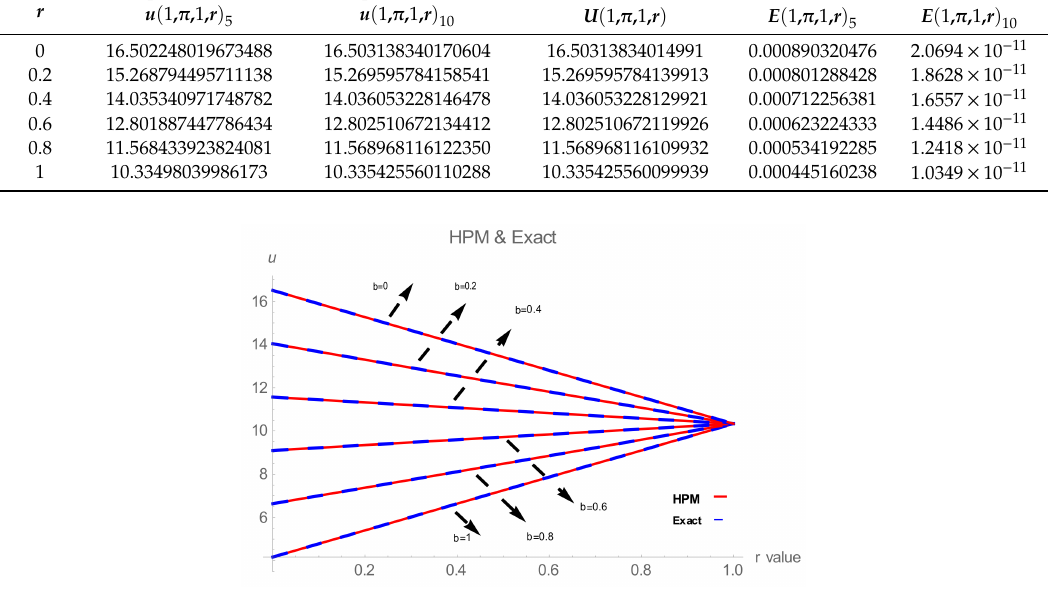
Figure 7. Comparison of the exact and tenth-order double parametric fuzzy HPM solutions of Equation (31) at t = π , x = 1 for di ff erent values of r , b ∈ [ 0,1 ] .